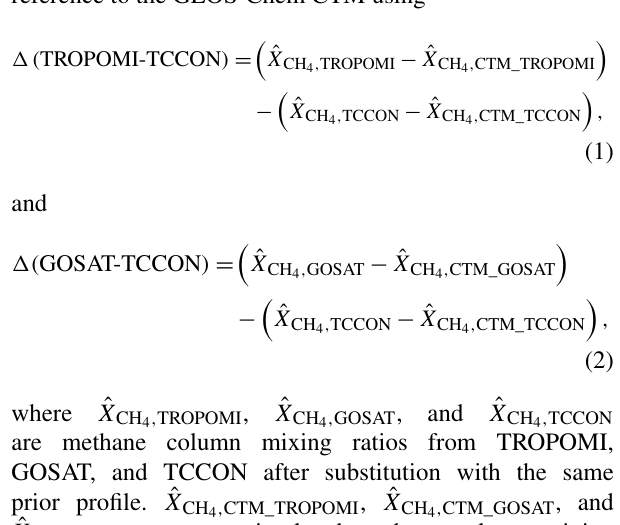
Figure 2. Biases of TROPOMI and GOSAT methane ( X CH trievals relative to TCCON. Values are averages for May 2018– April 2019 at each of the 21 sites of the TCCON network and have been corrected for differences in averaging kernels and prior verti- cal profiles on the 2 ◦ × 2.5 ◦ GEOS-Chem grid as described in the text. The large correlated biases at Zugspitze and Izana can be ex- plained by the high altitude of these TCCON sites. Statistics for the other 19 sites are given in the inset including the mean bias (MB), the regional bias (RB) calculated as the standard deviation of the bias between satellite and individual TCCON stations, and the co- efficient of determination ( R 2 ) between the TROPOMI and GOSAT